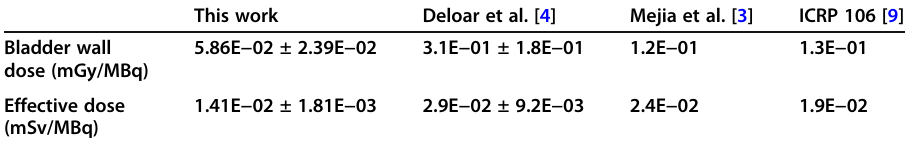
Table 5 Comparison of bladder wall dose and effective dose This work Deloar et al. [4] Mejia et al. [3] ICRP 106 [9] Bladder wall dose (mGy/MBq) Effective dose